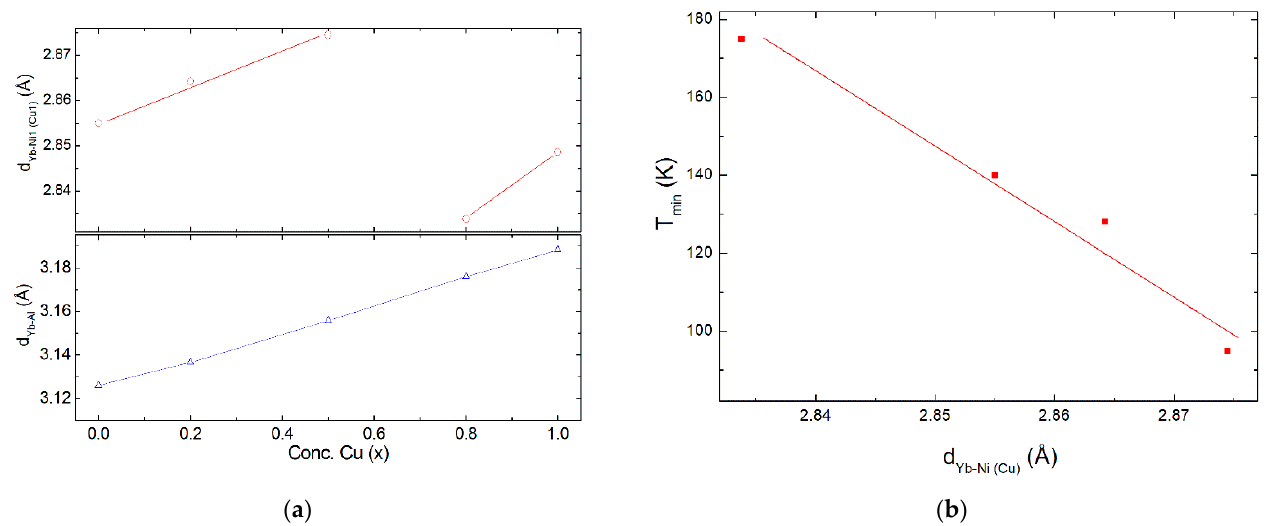
Figure 7. ( a ) Dependence of the distance between Yb and transition-metal atoms (Ni and Cu) (d Yb–Ni(Cu) ) and Al atom (d Yb–Al ) as a function of the Cu concentration (x). ( b ) Temperature of the minimum in the electrical resistivity vs. d Yb–Ni(Cu). A simple correlation between both parameters is found.